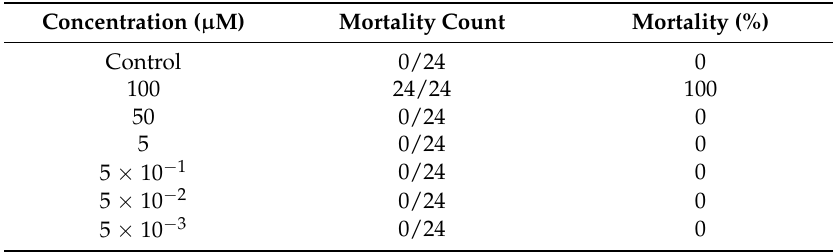
Table 1. Effect of 1-tosylpentan-3-one (1T3O) on zebrafish mortality. Zebrafish embryos were treated with 1T3O at concentrations of 10 2 , 50, 5, 5 × 10 − 1 , 5 × 10 − 2 , and 5 × 10 − 3 μ M 9 h to 4 days after fertilization, and zebrafish mortality was recorded. Results show that at concentrations of 50, 5, 5 × 10 − 1 , 5 × 10 − 2 , and 5 × 10 − 3 μ M, no mortality was observed.